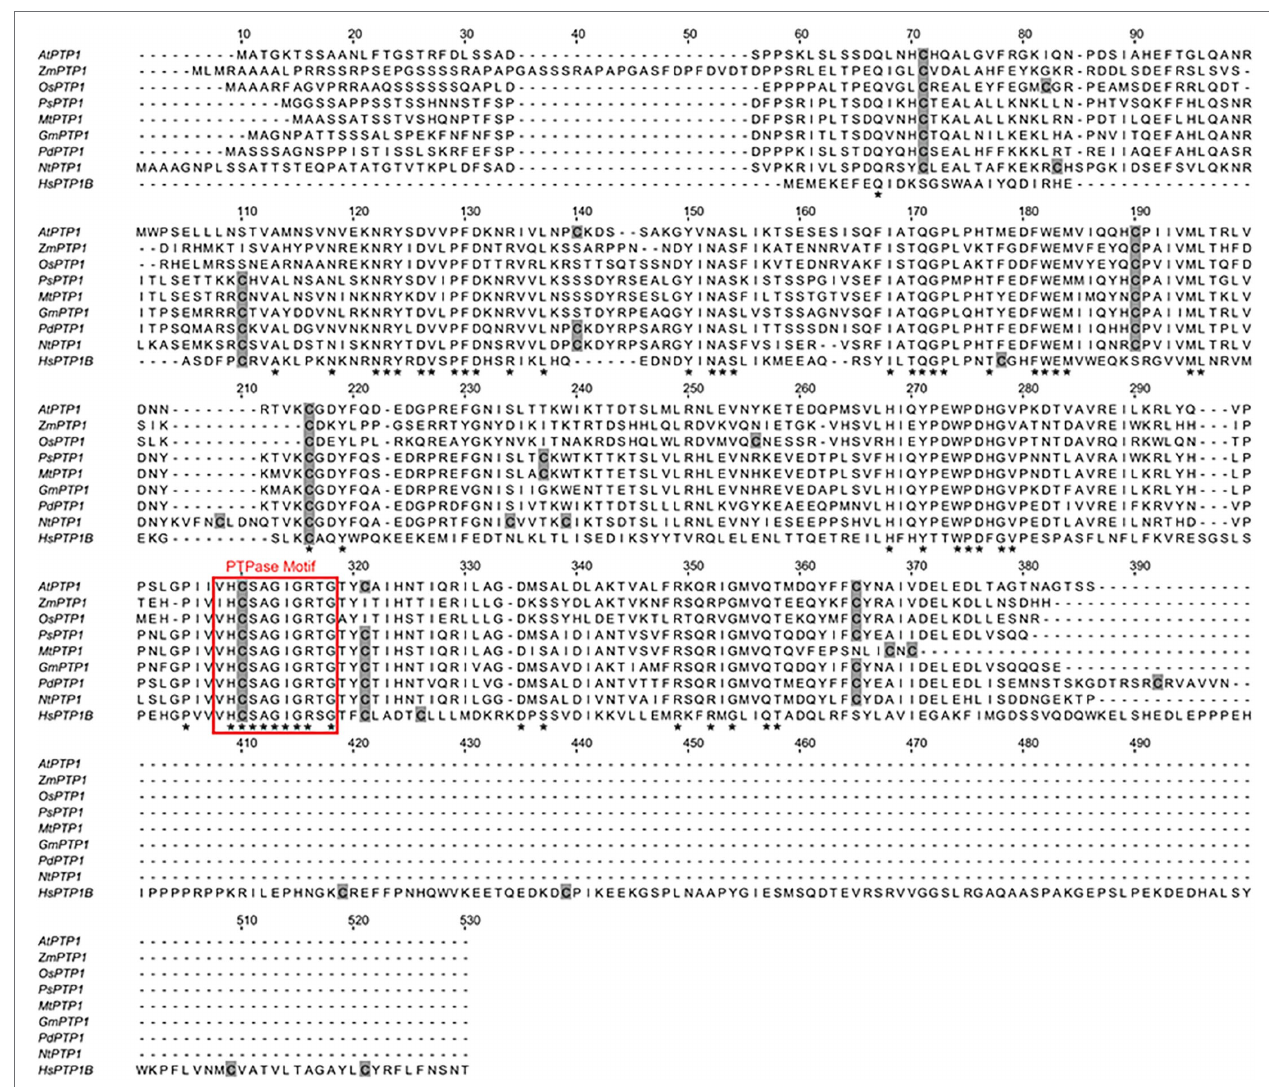
FIGURE 1 | Sequence alignment of eight plant Protein Tyrosine Phosphatase 1 (PTP1) proteins, including Arabidopsis thaliana Protein Tyrosine Phosphatase 1 ( At PTP1), and the human PTP1B protein. Perfectly conserved amino acid residues are indicated by stars. Cys residues are indicated in gray. The typical conserved PTPase signature motif is highlighted by a red frame. The sequences compared are as follows: Arabidopsis thaliana At PTP1, O82656; Zea mays Zm PTP1, NP_001149088; Oryza sativa Os PTP1, Q2QX07; Pisum sativum Ps PTP1, O82710; Medicago truncatula Mt PTP1, A0A072VQ92; Glycine max Gm PTP1,